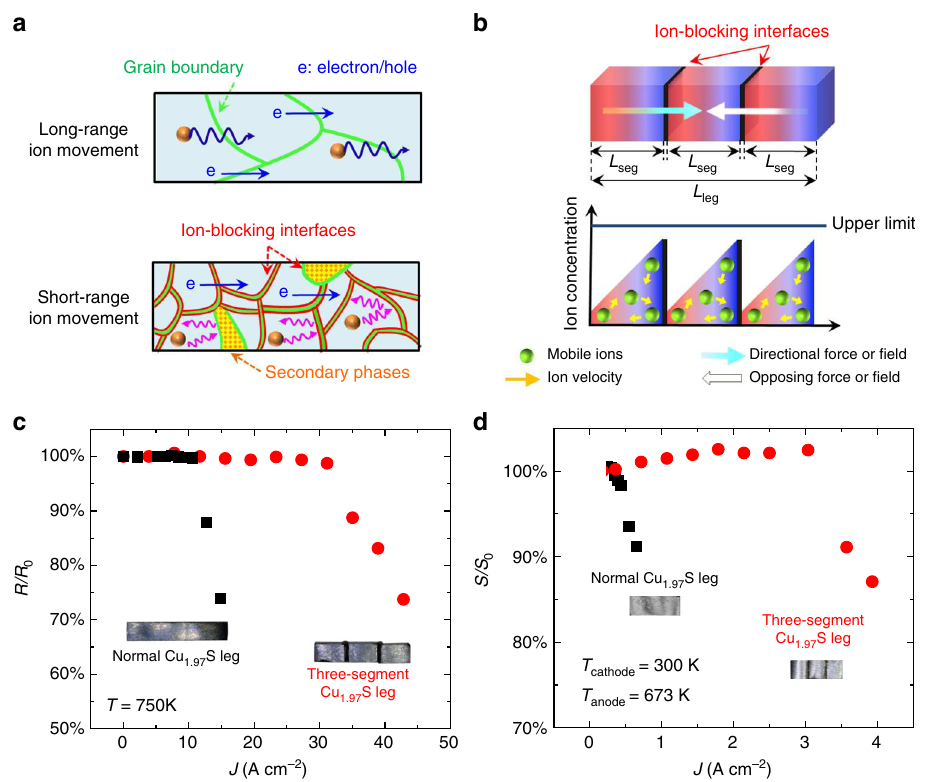
Fig. 4 Ion-blocking strategy to improve stability in thermoelectric ion conductors. a Schematic for limiting the ion movement by including thin electron- conducting and ion-blocking interfaces; either grain boundaries (red areas) or a secondary phase (yellow areas). b Schematic of ion-blocking electrically conducting interfaces that allow the concentration pro fi le to be reset at each interface so that the ion concentration does not ever reach the upper limit. c Relative resistance variation ( R / R 0 ) as a function of current density for different Cu 1.97 S samples at a constant temperature of 750 K without a temperature difference. d Relative Seebeck coef fi cient variation ( S / S 0 ) as a function of current density for different Cu 1.97 S samples under the condition of temperature difference ( T anode = 673 K and T cathode = 300 K). The insets in ( c ) and ( d ) show the optical images of the measured Cu 1.97 S samples. The critical current density was measured across the segment in the